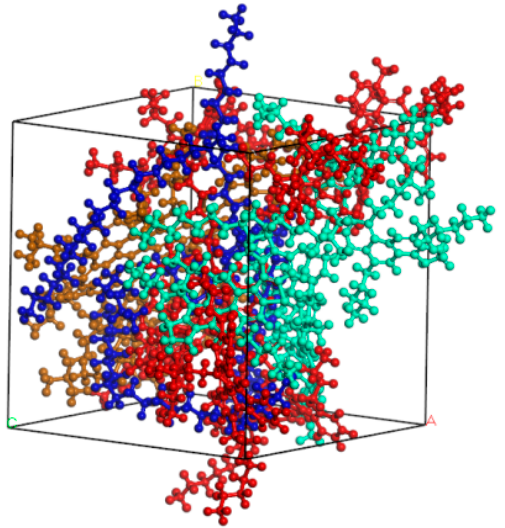
Figure 1. Three-dimensional structure diagram of the four components of asphalt: ( a ) asphaltenes; ( b ) resins; ( c ) saturates; and ( d ) aromatics. Note: white atoms = H, black atoms = C, yellow atoms = S, blue atoms = N, red atoms = O.